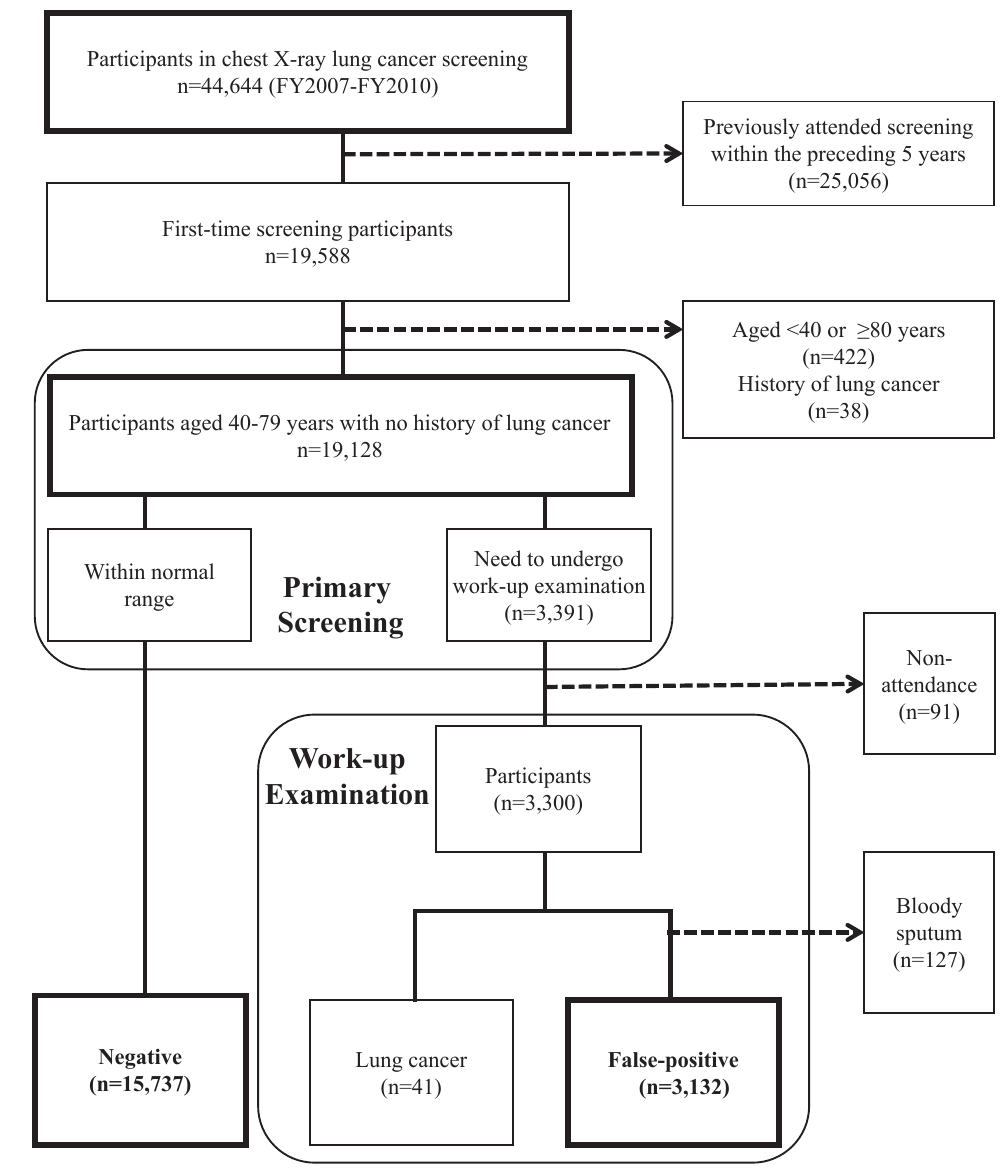
Figure 2. Selection of the study cohort. First-time lung cancer screening participants aged 40 – 79 years with no personal history of lung cancer, who had undergone work-up examinations, and who had no bloody sputum were included in the analysis. The study cohort consisted of 15737 participants with negative results and 3132 participants with false-positive results. FY, fi scal